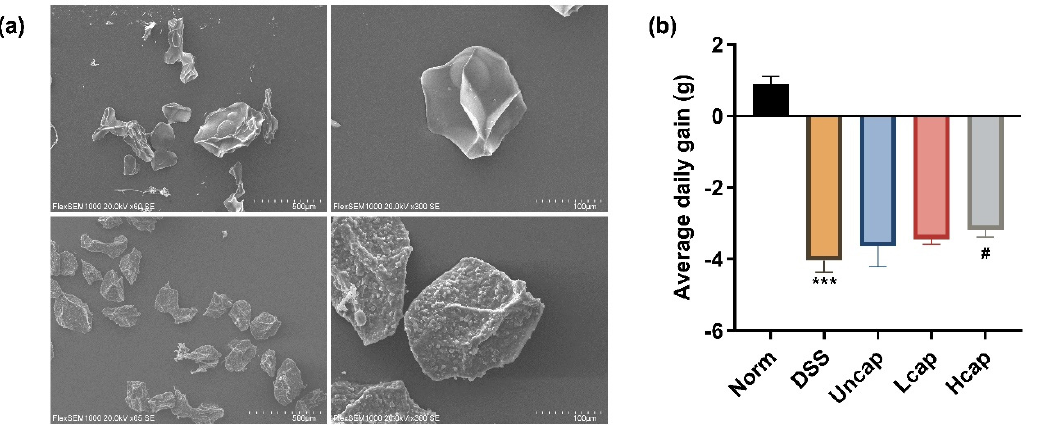
Figure 1. S. spongiosa polysaccharides attenuated weight loss in colitis mice. ( a ) Morphological characterization of S. spongiosa polysaccharides by scanning electron microscopy (SEM). ( b ) The average daily gain of mice during colitis. The values are reported as means ± SD ( n = 8). *** p < 0.001 vs. Norm group; # p < 0.05 vs. DSS group.